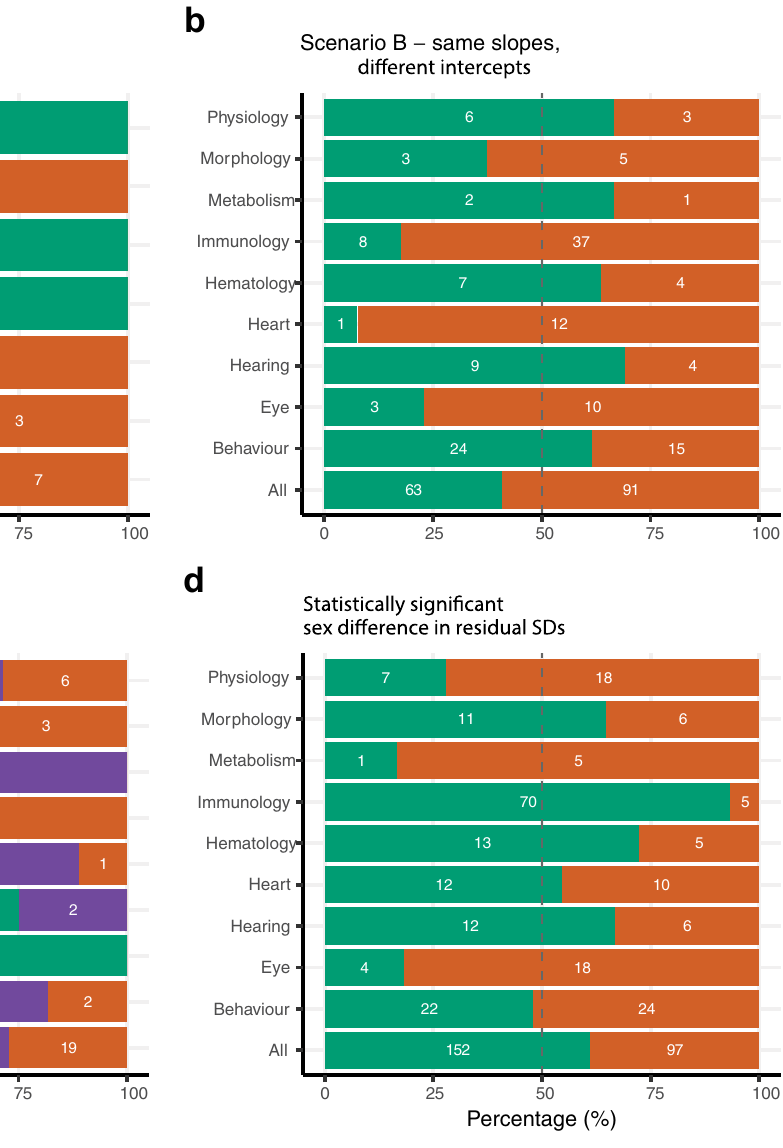
Fig. 2 | Sexbiasesfor phenotypic traitsin mice,arrangedin functional groups. Sexbiasrepresentsagreaterparametervalue(slope,intercept,variance)inonesex compared to the other. Colours represent signi fi cant differences in trait values between the sexes (green = male biased, orange = female biased). The number of traits that are either female biased (relative length of orange bars) or male biased (relativelengthofgreenbars)areexpressedasapercentageofthetotalnumberof traits in the corresponding group. Numbers inside the green bars represent the numbers of traits that show male bias within a given group of traits, values inside